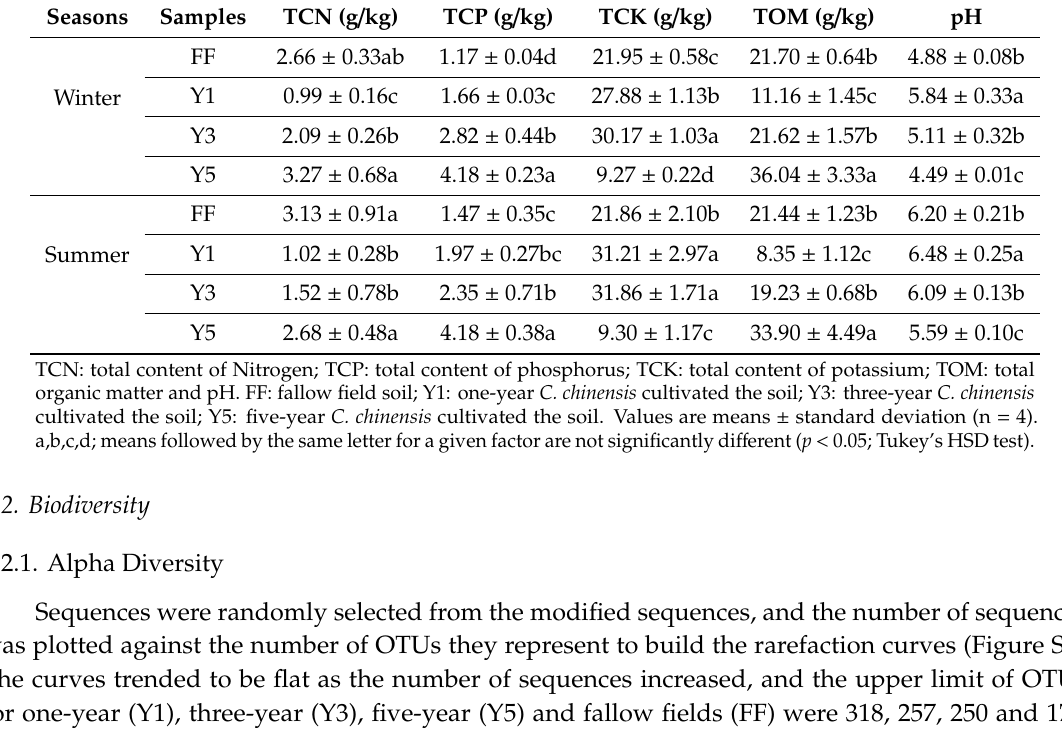
Table 1. Physiochemical characteristics of rhizospheric soil in winter and summer.